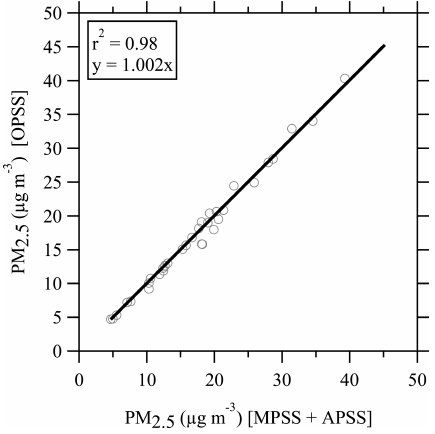
Figure 11. Correlation between the PM 2 . 5 derived from the OPSS and MPSS + APSS.